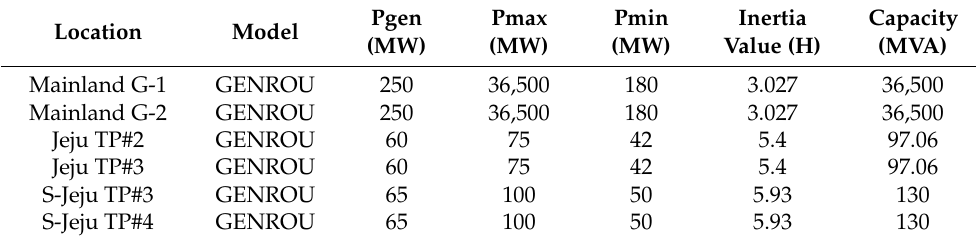
Table A1. The simplified model’s generator model